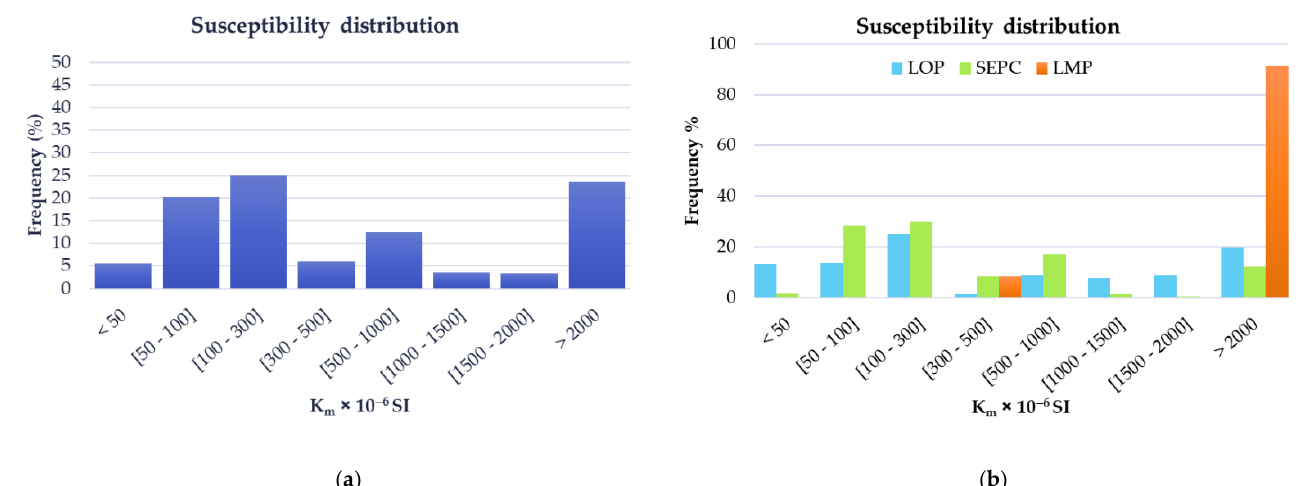
Figure 2. Relative frequency magnetic susceptibility histograms: ( a ) for all the studied granites; ( b ) for the plutons; LOP: Lamas de Olo Pluton; SEPC: Santa Eulália Plutonic Complex; LMP: Lavadores- Madalena Pluton (total of measured samples = 1162).